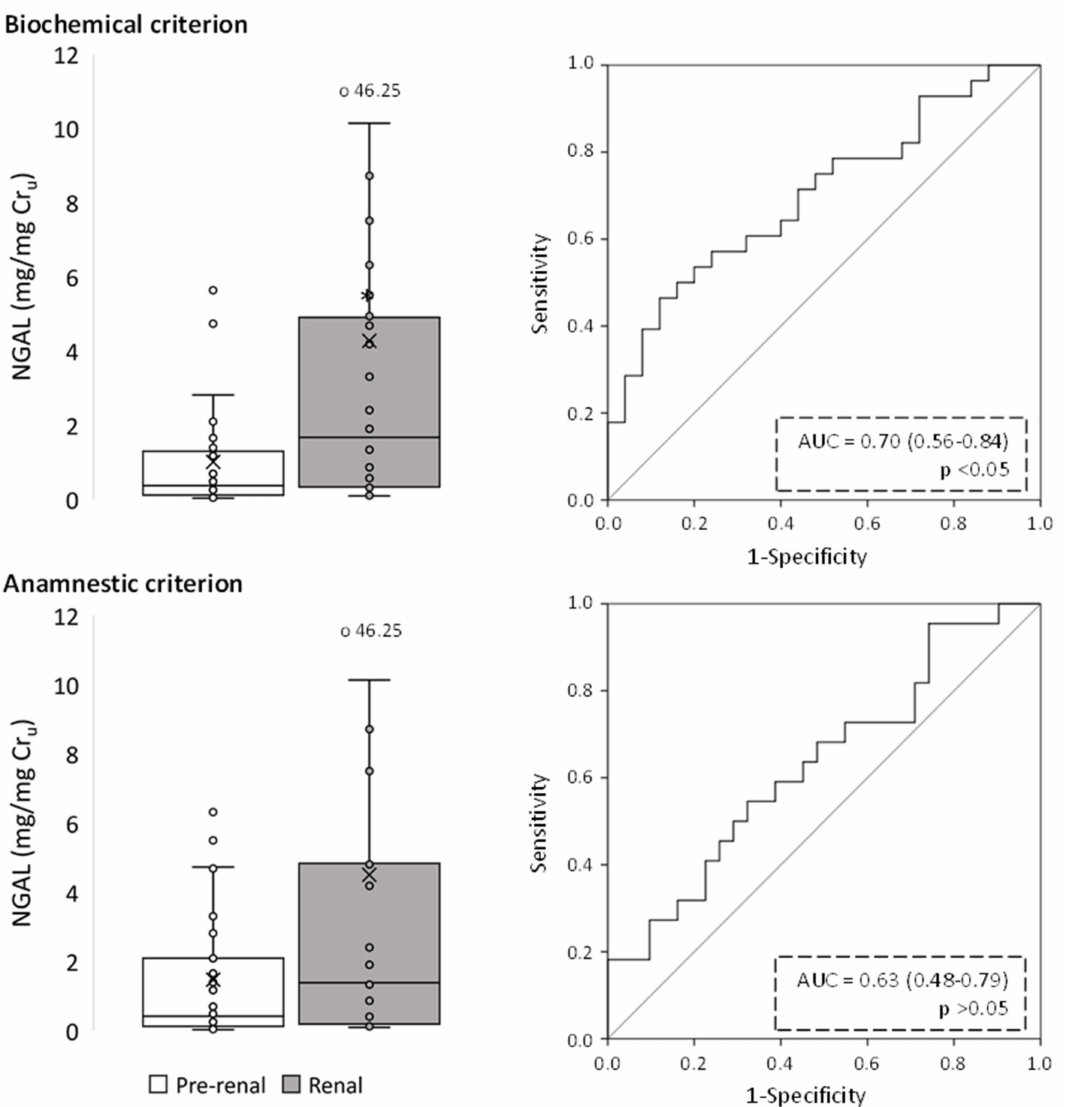
Figure 5. Urinary NGAL levels of pre-renal and renal AKI patients following classification by biochemical and anamnestic criteria, shown as box plots ( left panels) representing median values in mg of urinary NGAL per mg urinary creatinine (Cr u ), and ROC curves ( right panels). AUC: area under the ROC curve showing the pre-renal/renal classification efficacy of urinary NGAL. The × in box plots represents the median value. *, p <